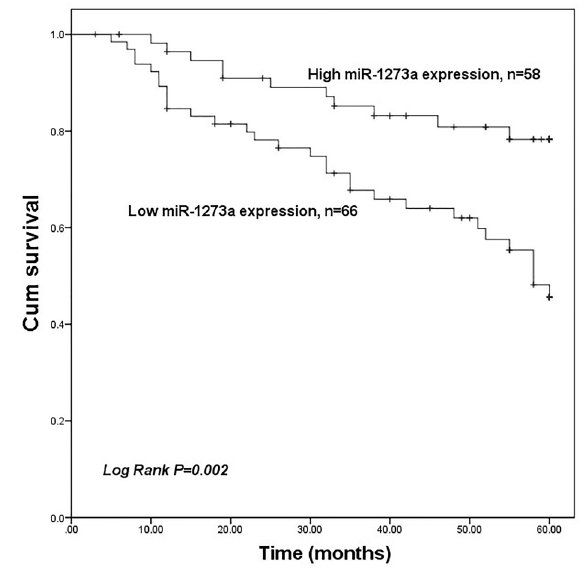
Figure 2. Kaplan-Meier survival curves for the patients with colon cancer. Overall survival in the patients with low miR-1273a expression was poor compared with the patients with high miR- 1273a expression (log-rank